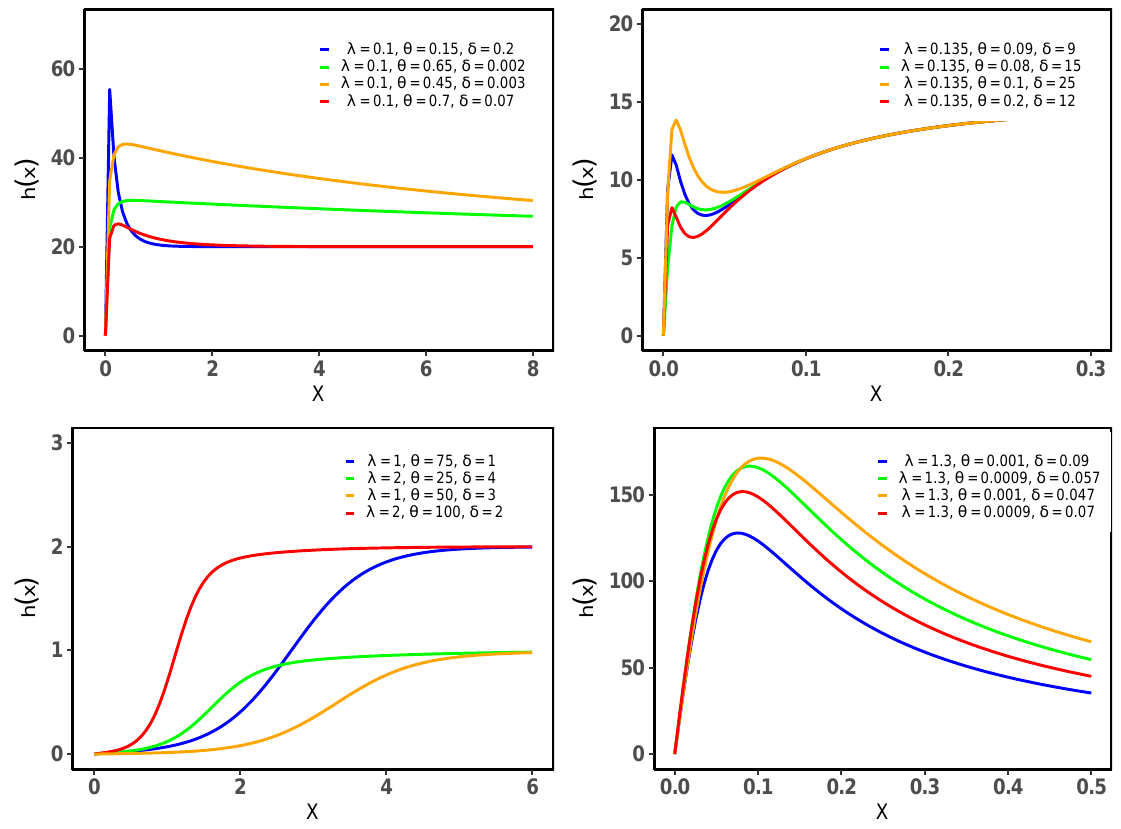
Figure 2. Plots of the hrf of the HEB